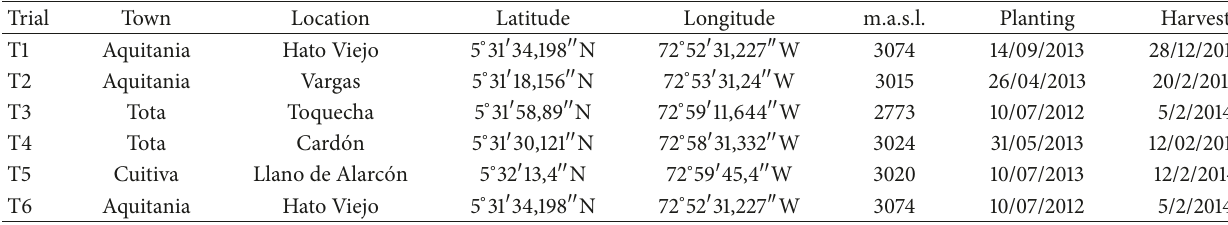
Table 1: Experimental location used to evaluate bunching